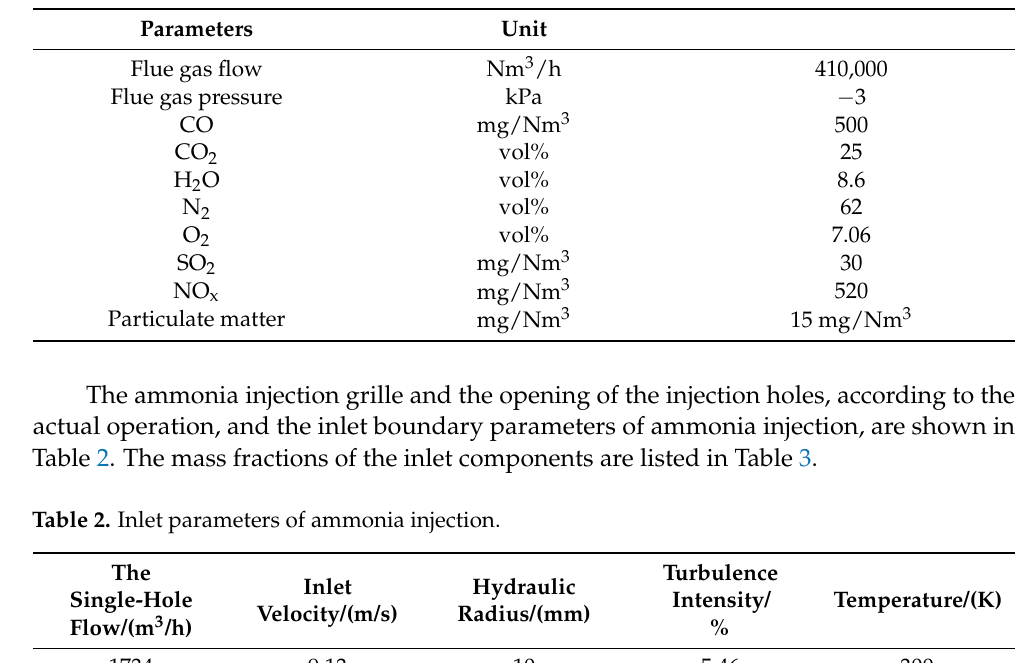
Table 1. SCR system operating parameters.